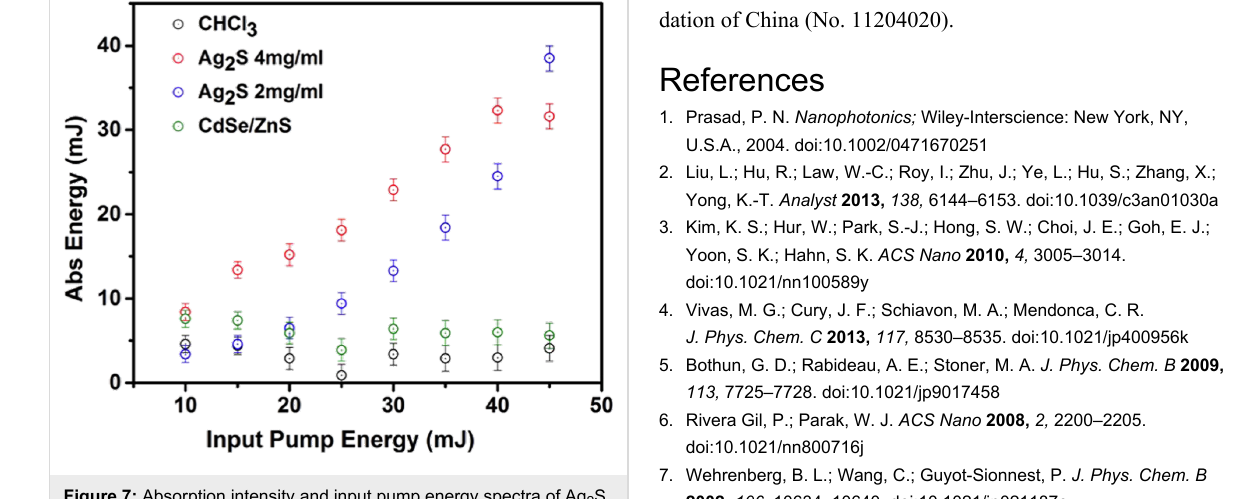
Figure 7: Absorption intensity and input pump energy spectra of Ag 2 S.